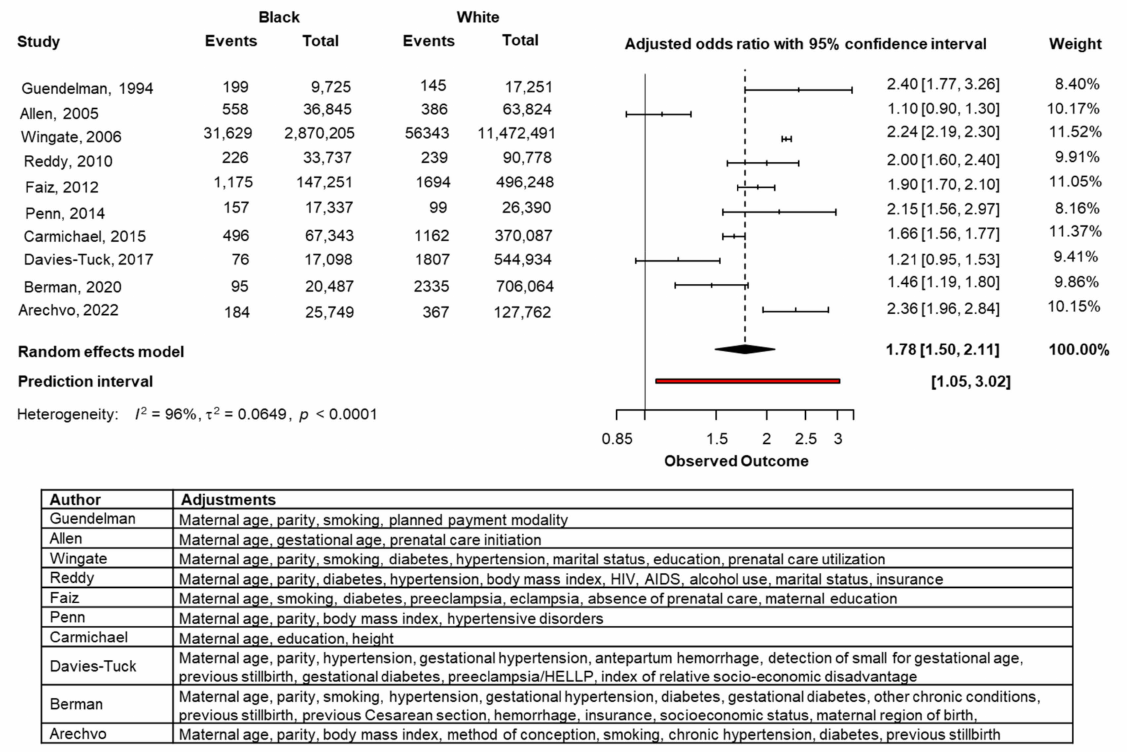
Figure 3. Forest plots of odds ratio for stillbirth in Black women compared with White women with 95% confidence intervals (CI) and pooled summary statistics using a bivariate random-effects